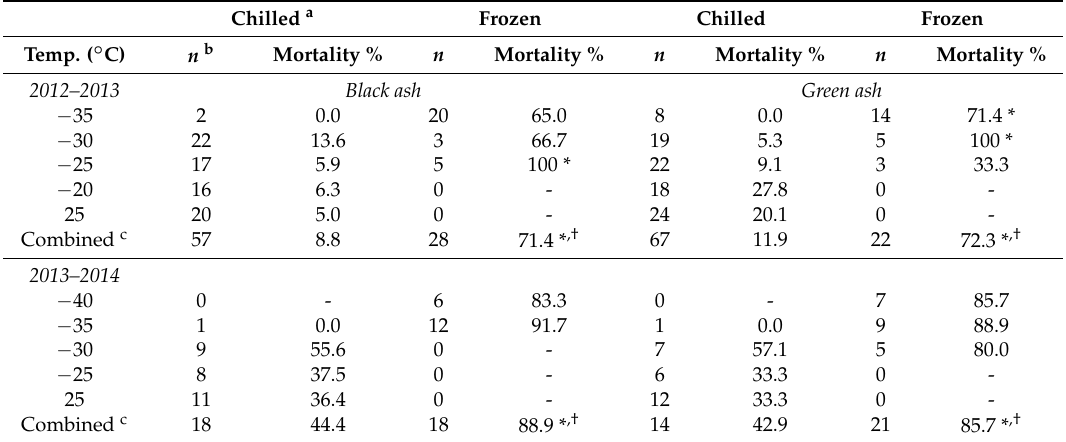
Table 2. Mortality of chilled and frozen A. planipennis larvae from green and black ash in the winters of 2012–2013 and 2013–2014 at one week after acute exposure to a subzero temperature. Chilled a Frozen Chilled Frozen Temp. ( ◦ C) n b Mortality %